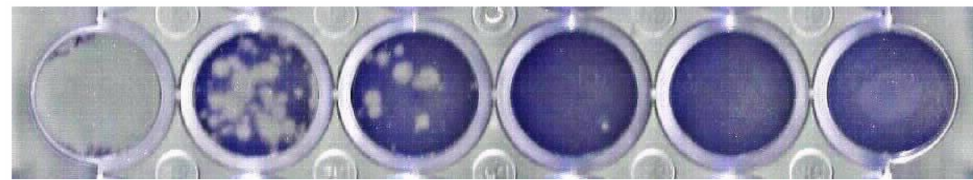
Figure 3. Mengovirus titration in Vero E6 cells cultivated in wells of a P24-well plate. Titration performed in virus-production medium (CO 2 independent medium supplemented with 2% fetal bovine serum) supplemented with 2% Sephadex G50. The wells were inoculated with 0.1 mL of the following dilutions of the virus: 10 − 2 , 10 − 3 , 10 − 4 , 10 − 5 (from left to right in the four first wells) and two controls were inoculated with 0.1 mL of virus-production medium (the two last wells). RNA extracted from the concentrated viral suspension produced in Vero E6 cells (corresponding to 4 mL of the viral suspension, i.e., 8 × 10 6 PFU) was RT-qPCR positive for mengovirus RNA (Cq value of 14.4 when evaluated by the RT-qPCR protocol also applied to the RNAs extracted from water